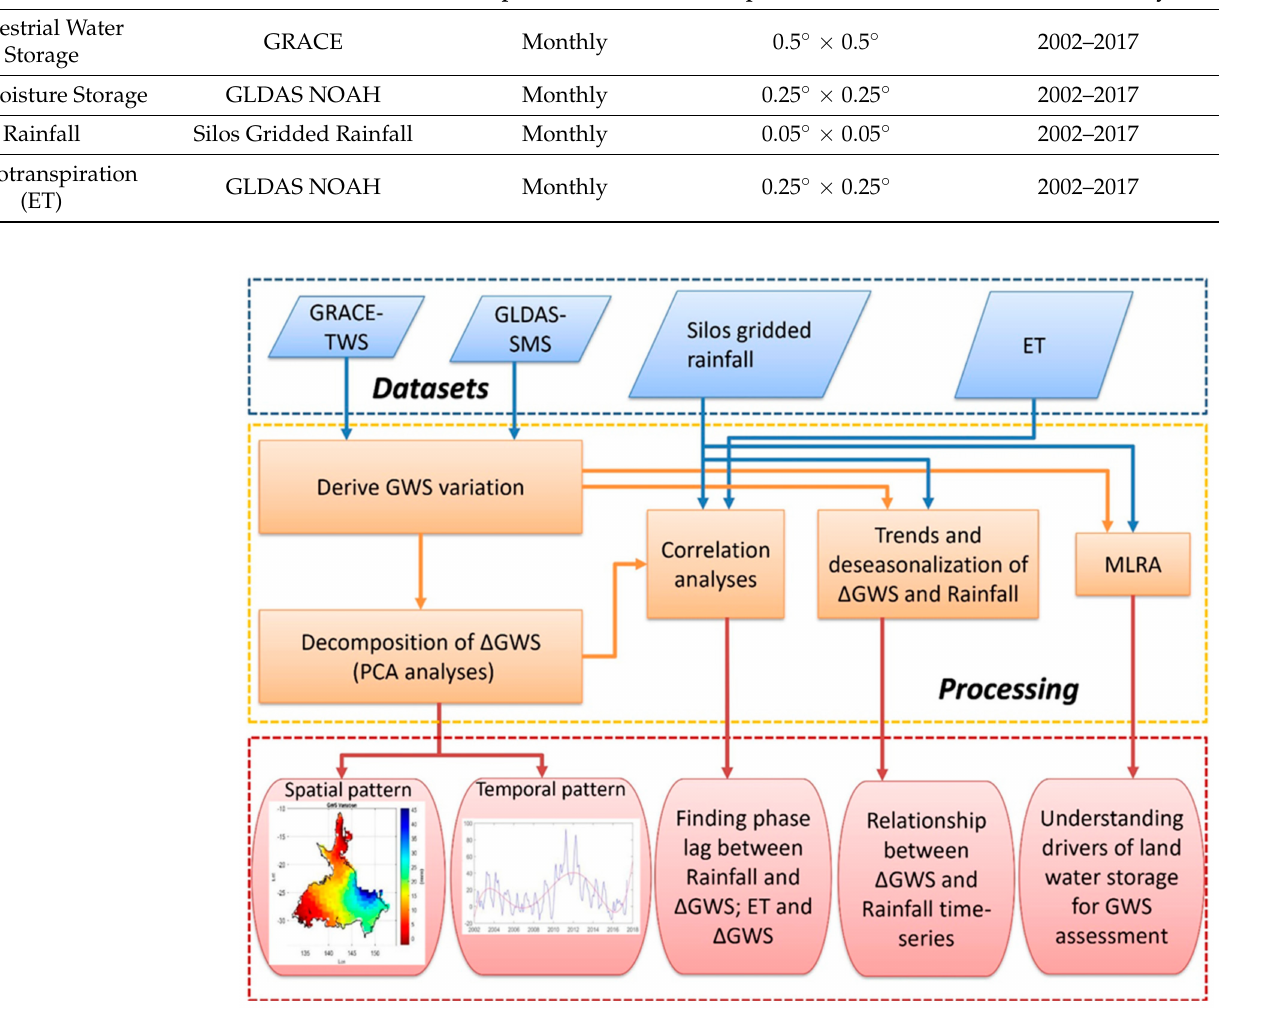
Table 1. Summary of the datasets used in the study to characterize groundwater storage variations in the GAB. Data